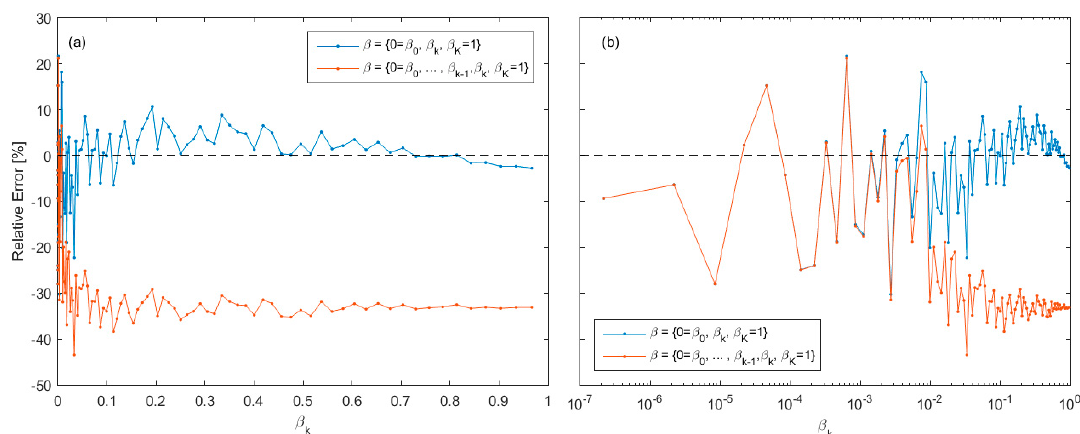
β values expressed in ( a ) standard (cid:8) β β = 0, β = 1 (cid:9) and a β β β= = = β K 0 k , { 0, , 1} (cid:8) β ... , β β 0 k K = 0, β = 1 (cid:9) , given K = 100 and α = 0.3. Note that the K 0 1 , k , { , given K=100 and . (cid:8) β (cid:9) β ... , β is the SS K 0 , 1 ,